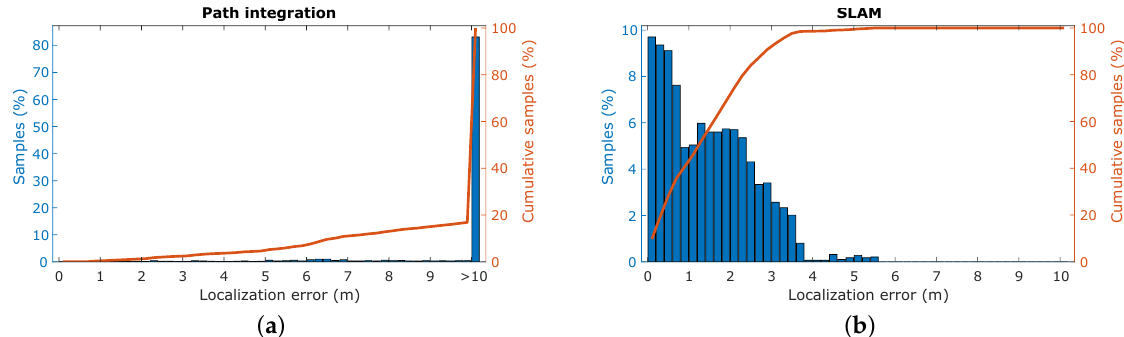
Figure 8. Simultaneous localization and mapping metrics. ( a ) The distribution of the positional error for the path integration compared to the ground truth. ( b ) The distribution of the positional error for the SLAM trajectory compared to the ground